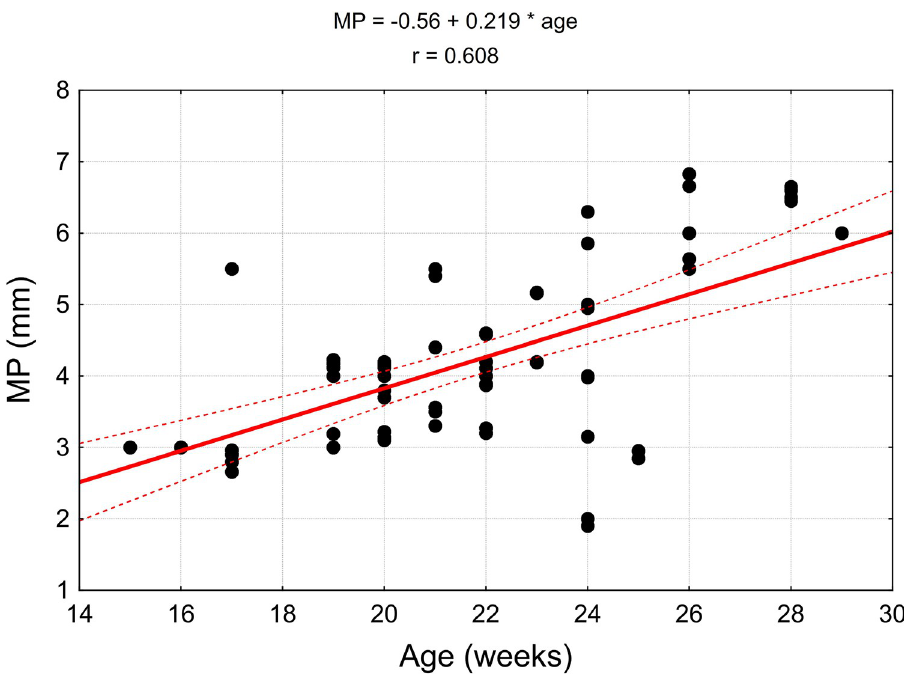
Fig 16. Correlation diagrams for the width of the piriformis muscle (MP) and width of the main branch to the gluteus medius muscle (MED) with the age of the fetus.